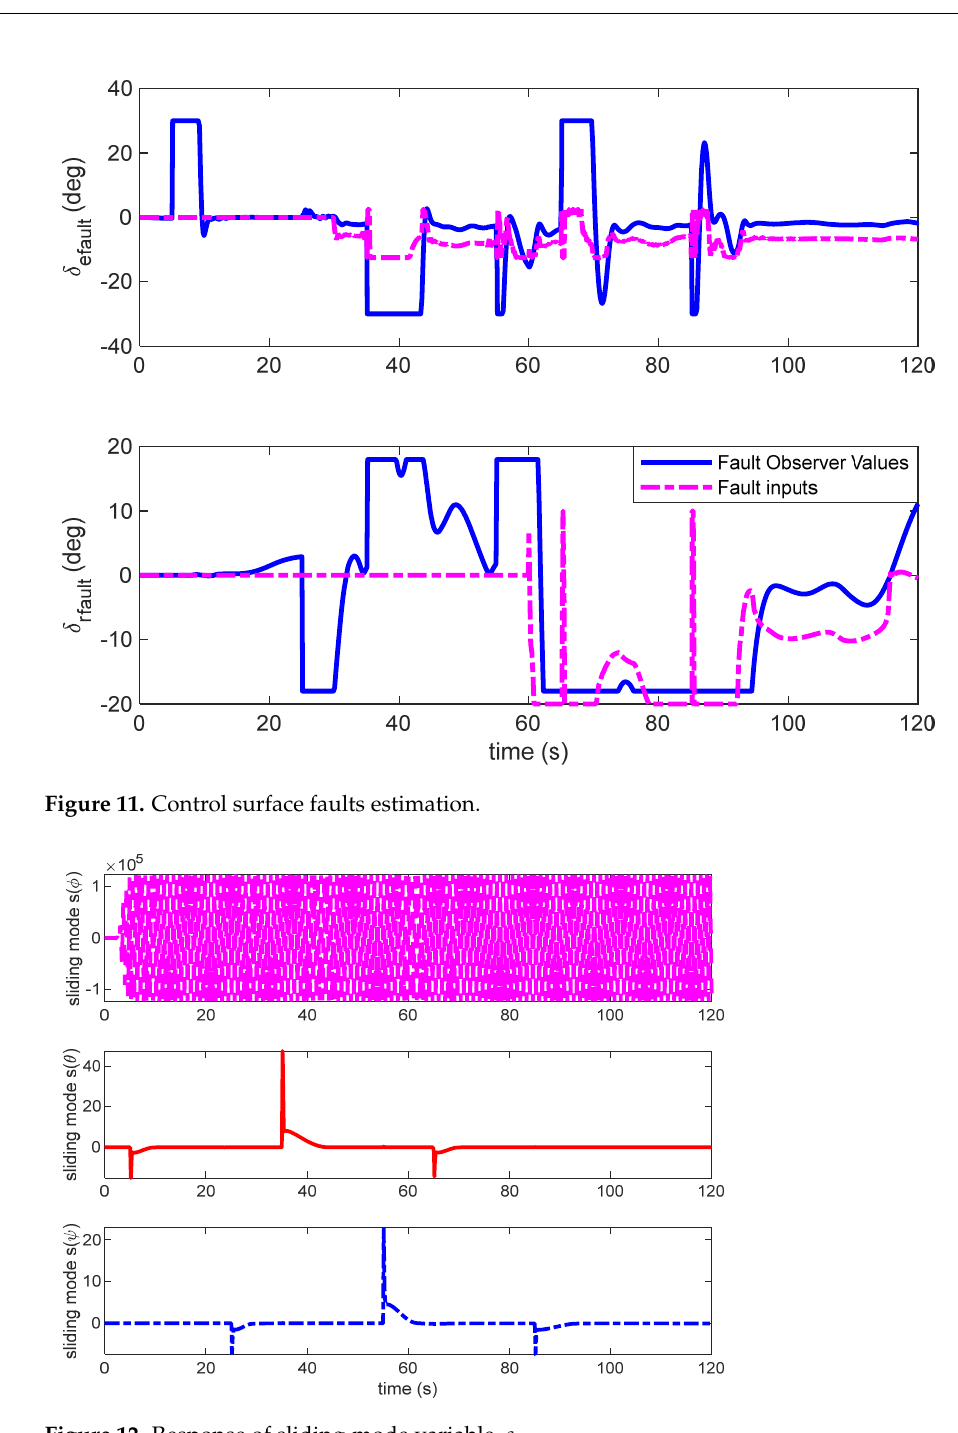
Figure 12. Response of sliding-mode variable, s.